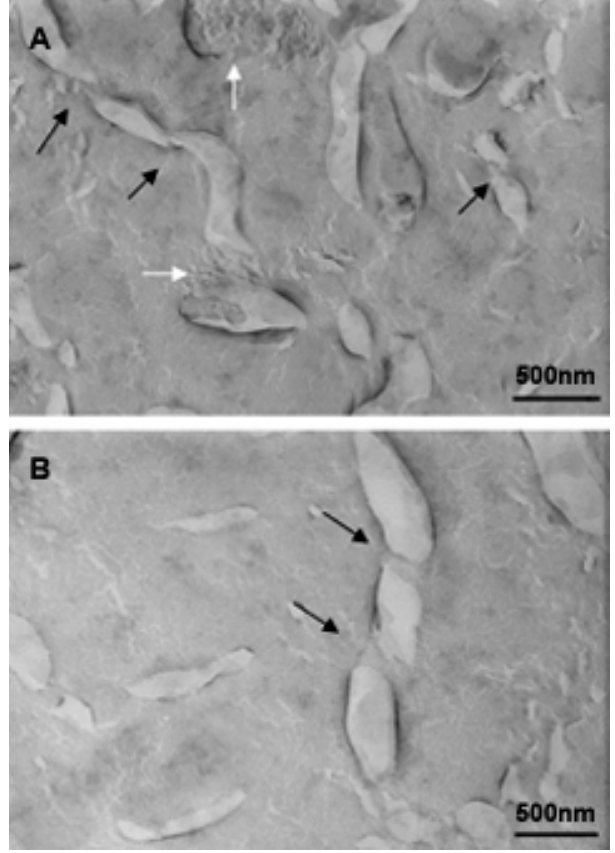
Figure 16. Micrographs of bicellar sample containing Cer at 20 °C. Two different regions of the same sample. Black arrows indicate the twisted zones along the elongated aggregates. The white arrows in image A show the presence of small bicelles in the range of 20–50